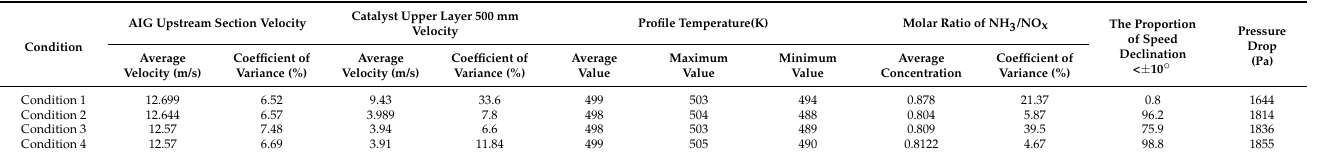
Table 6. Summary of the results of the four conditions.